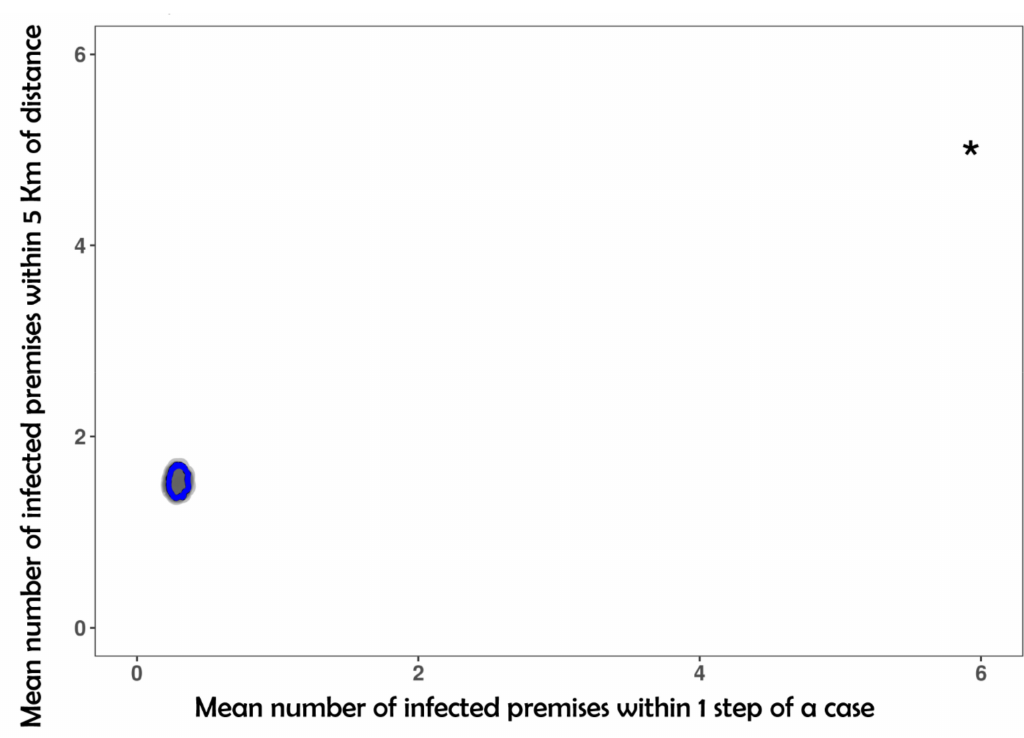
Figure 5. Graphical results of the k-test for the cumulative network considering a threshold of 5 km and k = 1 step in the network. The star indicates the observed mean of positive premises within 1 step in the network (x-axis) and positive premises within 5 km (y-axis). The grey-shaded region represents the null distribution of the k-statistic when positive premises were randomly distributed within the network. Blue line represents 95% of the null distribution of positive premises within one step in the network.